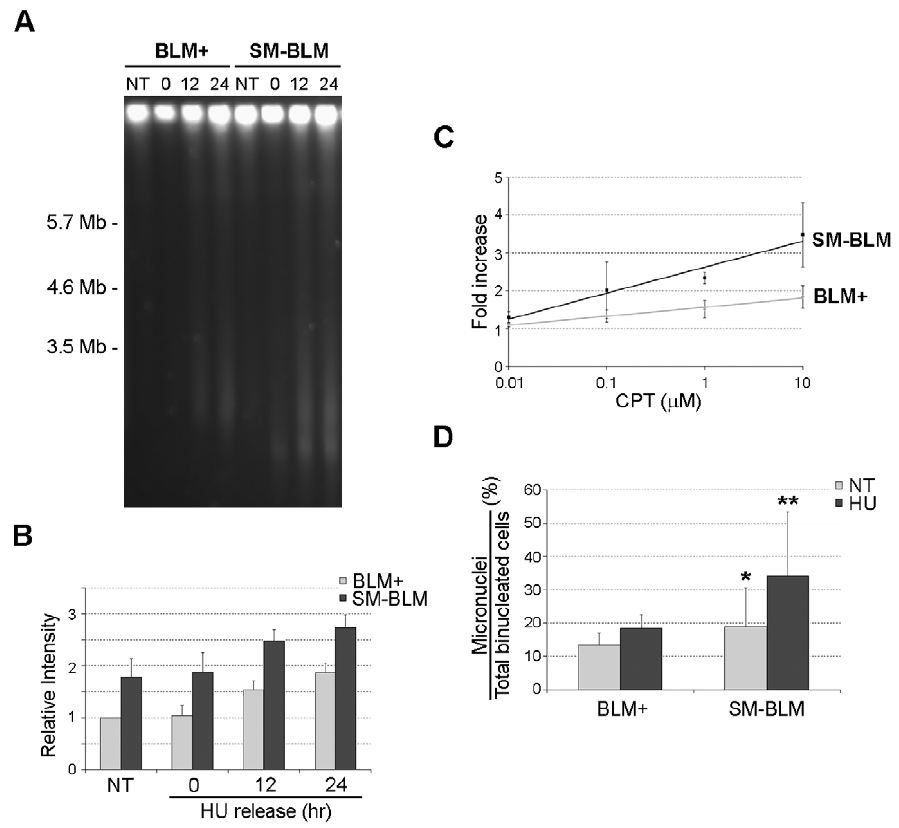
Figure 2. SUMO-mutant BLM cells accumulate excess DSBs at damaged replication forks. (A) Pulsed-field gel showing the analysis of untreated BLM + and SM-BLM cells (NT) and cells treated with HU for 24 h (0 time) followed by release into normal medium for 12 and 24 h. DSBs were visualized by DNA fragments that migrate into the gel, whereas intact DNA was retained in the well. (B) Quantification of DSBs after treatment with HU and release into normal medium. The bars represent the numbers of DSBs relative to untreated BLM + cells in two independent experiments with two clones of each type, and the error bars represent the standard deviations of the combined data. (C) Quantification of accumulation of DSBs after treatment with different concentrations of CPT for 3 h. Data points represent the numbers of DSBs relative to untreated BLM + or SM-BLM cells from a minimum of two experiments with two clones of each type. Error bars represent standard deviations of the combined data. (D) Quantification of HU- induced micronuclei. Cells were untreated or treated with 0.5 mM HU for 24 h, followed by incubation with cytochalasin-B for 28 h in theabsence of HU. The numbers of micronucleiwere counted in binucleated cells. A minimumof 500 binucleated cells were assessedundereach condition. Datapresented are the average of three experiments in three BLM + and three SM-BLM clones. The bars represent mean numbers of micronuclei, and error bars represent standard deviations of the combined data. * p =0.6, NT SM-BLM versus NT BLM + ; ** p , 10 2 3 , HU-treated SM-BLM versus HU-treated BLM + .